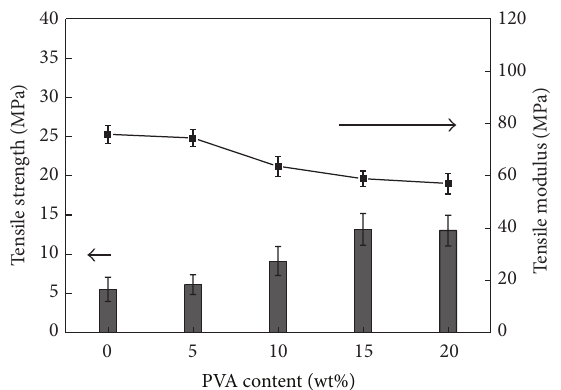
Figure 8: FTIR spectra of SPI/glycerol without and with